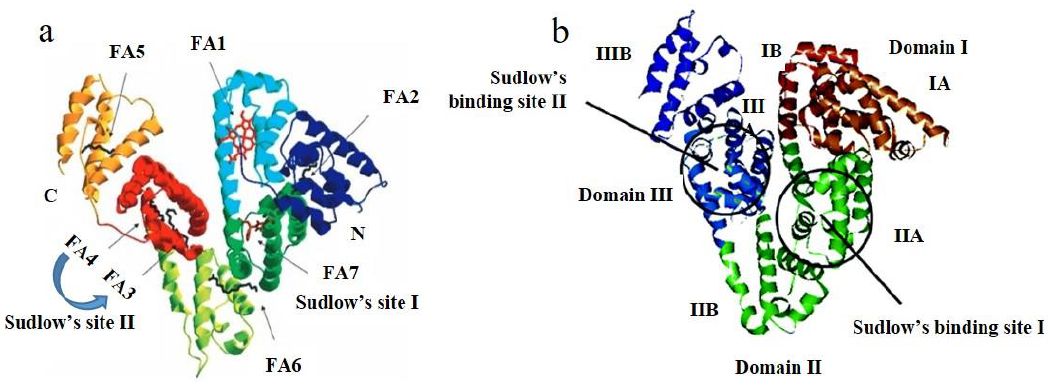
Figure 2. Structure and binding sites of human serum albumin (HSA) ( a ) (edited by [23]) and bovine serum albumin (BSA) ( b ) (edited by [30]).